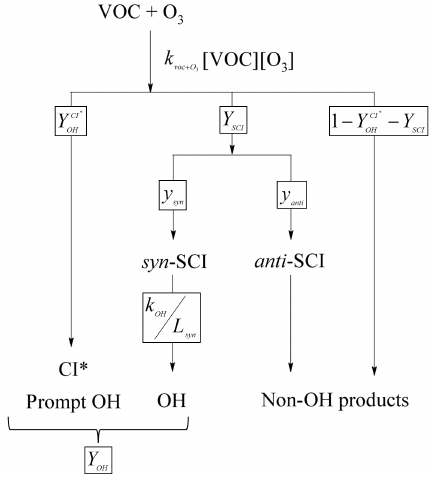
Figure 2. Schematic representation of the formation of OH from the ozonolysis of unsaturated VOCs.